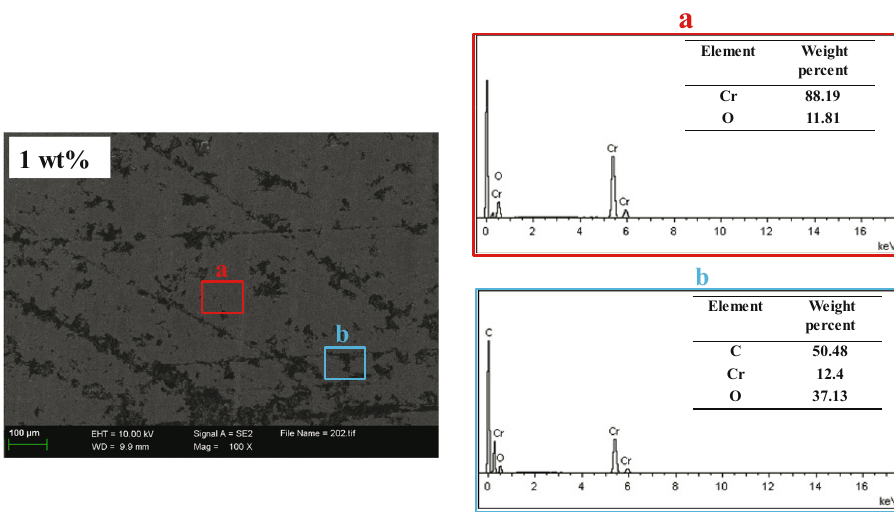
Figure 8: SEM micrographs and EDX spectra of Cr liner specimens after test ( a ) fl at zone and ( b ) defect